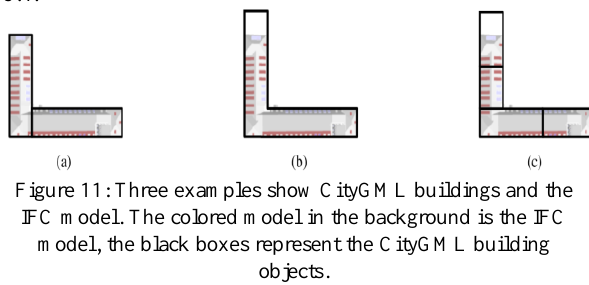
Figure 11: Three examples show CityGML buildings and the IFC model. The colored model in the background is the IFC model, the black boxes represent the CityGML building objects.